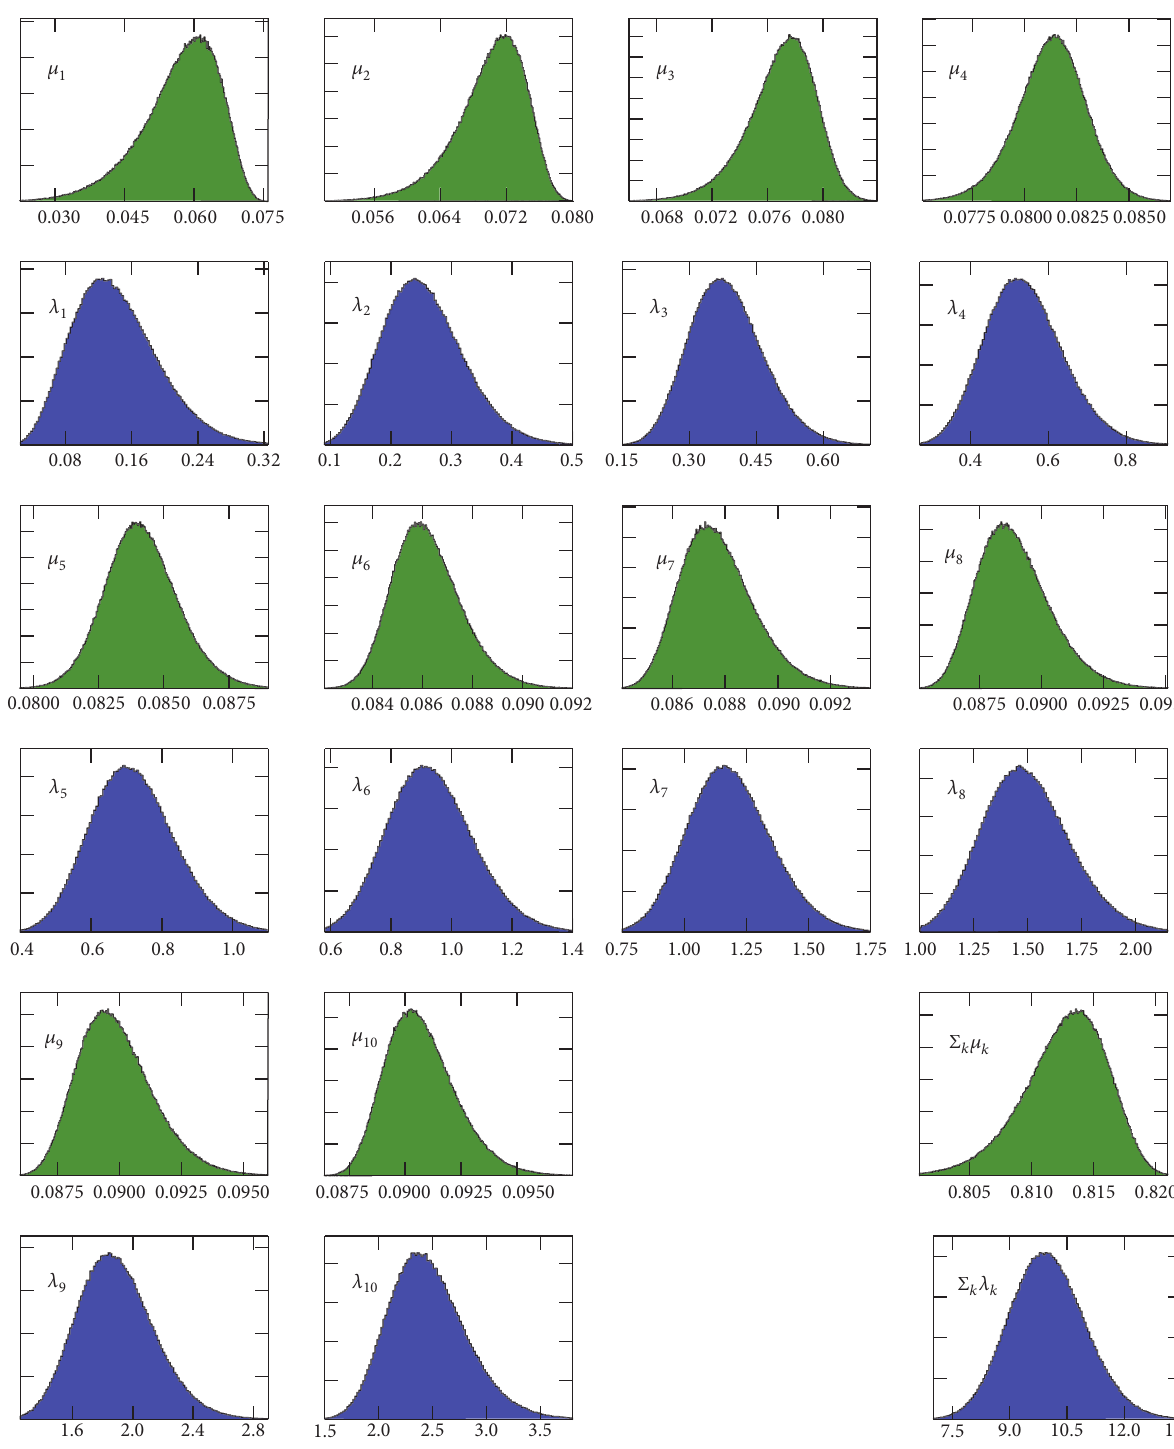
Figure 3: Monte Carlo simulation of the probability density function of the ordered eigenvalues 𝜆 𝑘 (even rows) and their truncated counterparts 𝜇 𝑘 at 𝜌 = 1 (odd rows) for the Wishart ensemble W 10 (20,20 −1 ⋅ I 10 ) . The last two plots (bottom right) display the distribution of the sum of